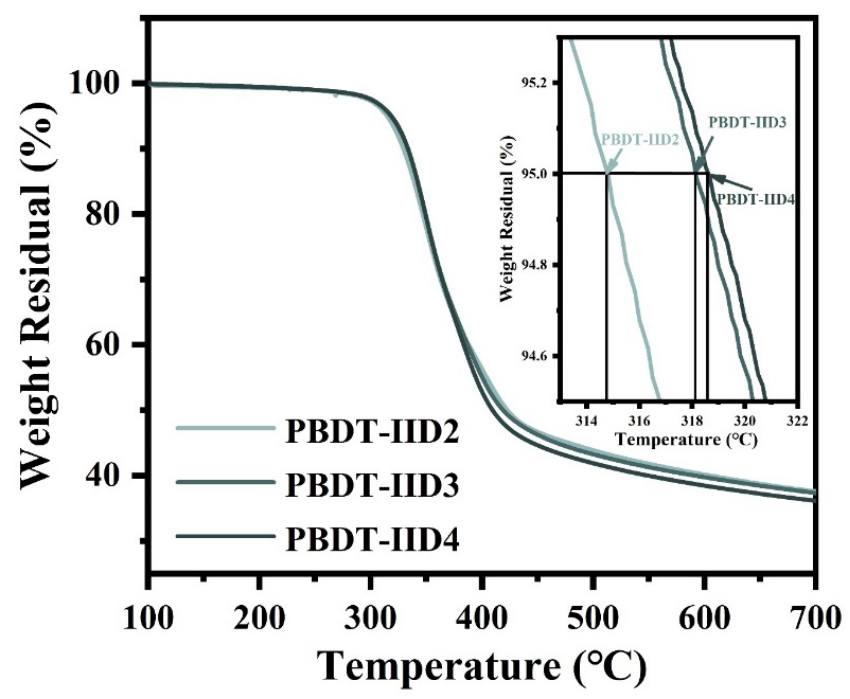
Figure 3. The thermogravimetric curves of PBDT-IID2, PBDT-IID3, and PBDT-IID4 under a nitrogen atmosphere.